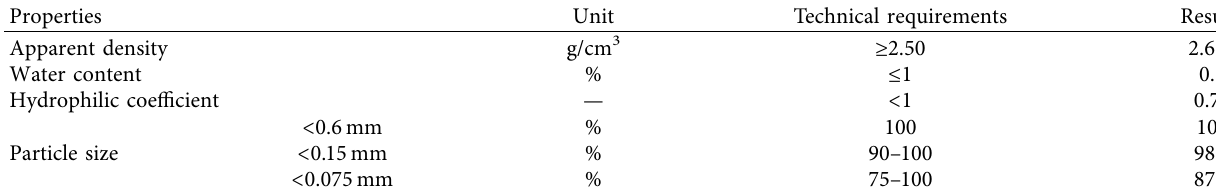
Table 3: Technical properties of filler.